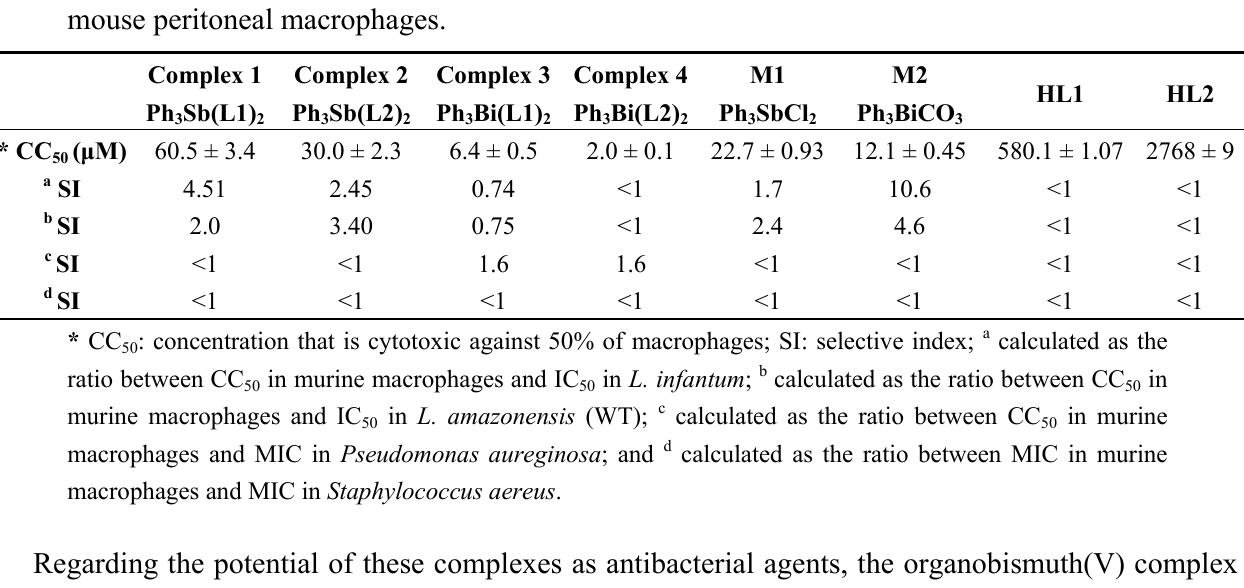
SbCl and Ph BiCO , and 3 2 3 3